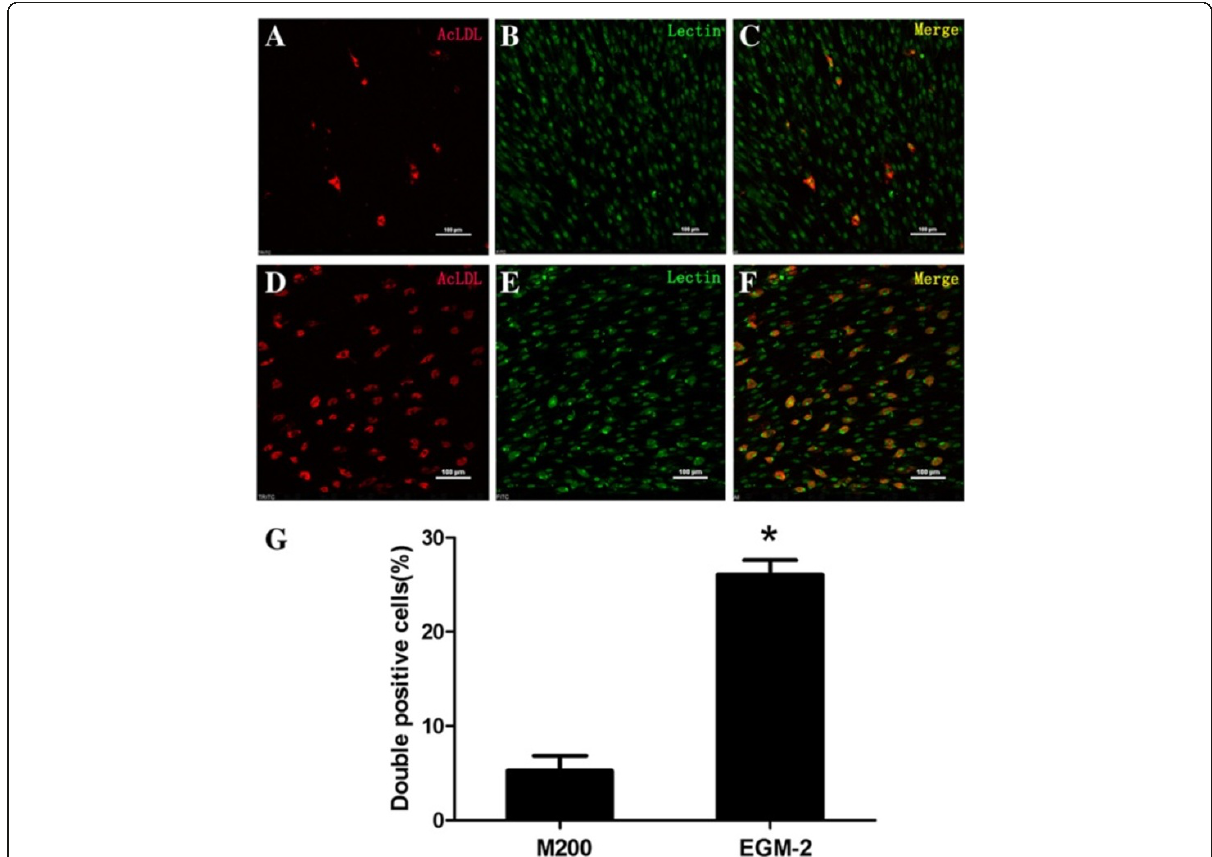
Figure 4 Characterization of cells in cultures by staining cells with FITC - lectin and examing uptake of Dil AcLDL. Unselected mononuclear EPCs were cultured on FN coated dishes and in M 200 or EGM-2 medium, and characterization was proceeded by uptake of Dil AcLDL (left, red) and FITC-lectin staining (middle, green). Double positive cells (right, merge) were observed in both M 200 (A-C) and EGM-2 (D-F) on the 19 th day after plating, but the number of double positive cells in EGM-2 was much more than in M 200 (G) . *, significantly different (P <0.05). Bar =100 μ